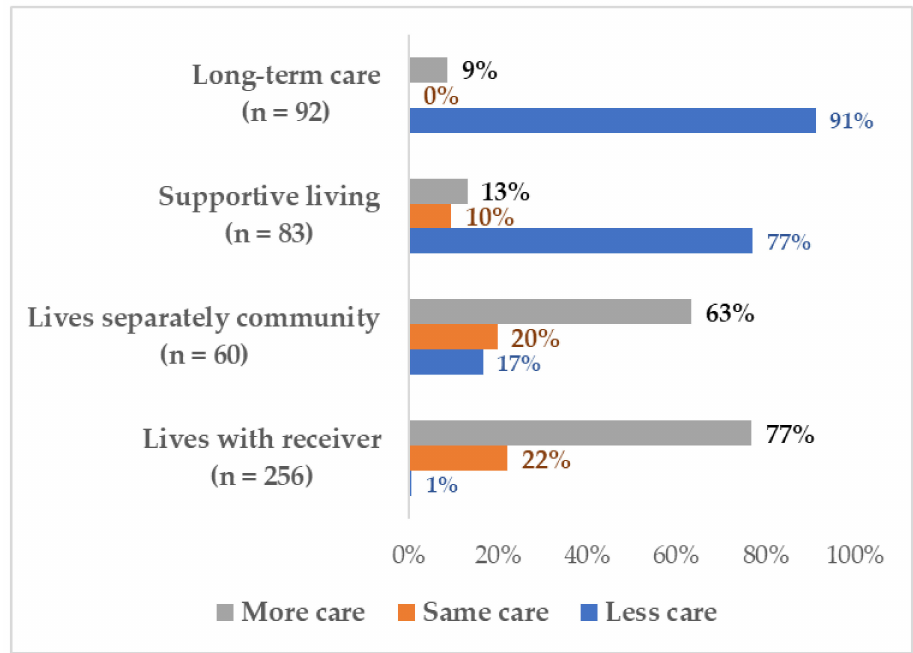
Figure 2. Proportion of caregivers providing more, equivalent, or less care by receiver residence during COVID-19. Table 2. Care hours per week (h/wk.) by care receiver’s living situation before the COVID-19 pandemic. <10 h/wk. 11–20 h/wk. 21–39